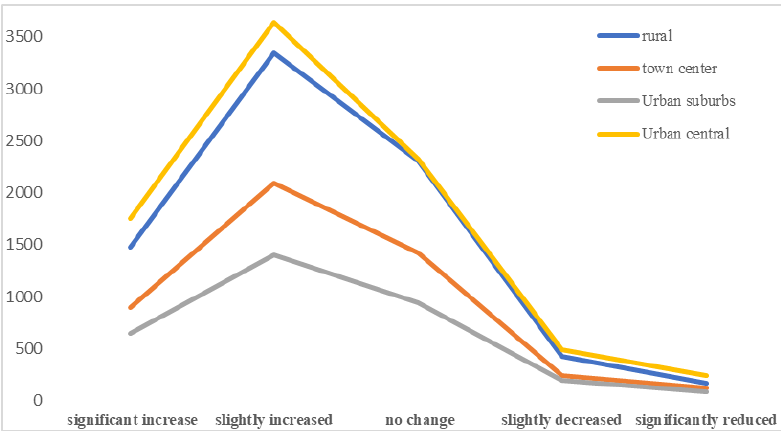
Figure 5. Lisa gathering of family relationship closeness.